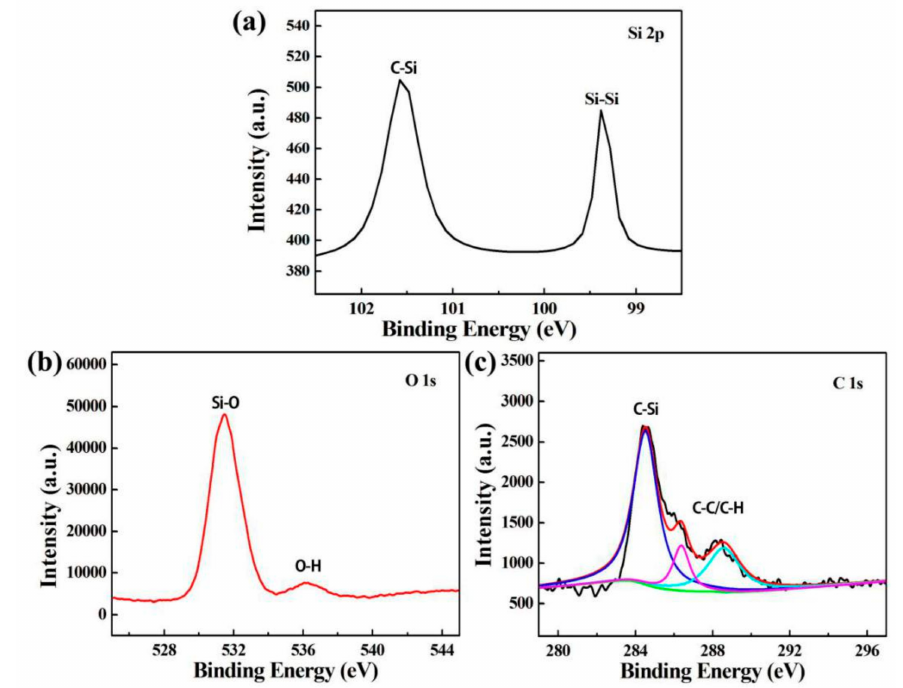
Figure 4. XPS spectra of ( a ): Si (2p) ( b ): O (1s) and ( c ) C (1s).